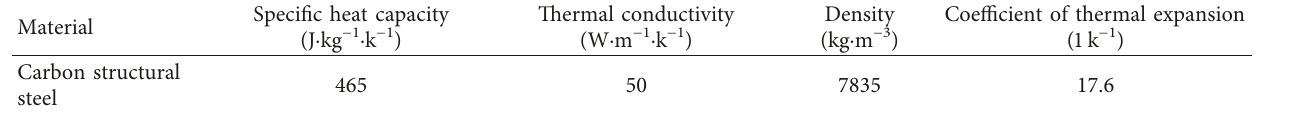
Table 1: Material parameters of temperature field.